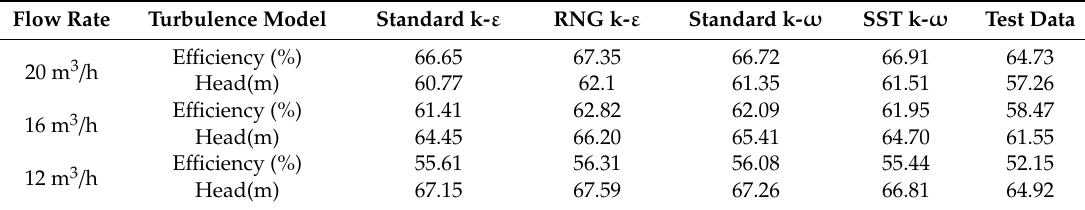
Table 3. Turbulence model